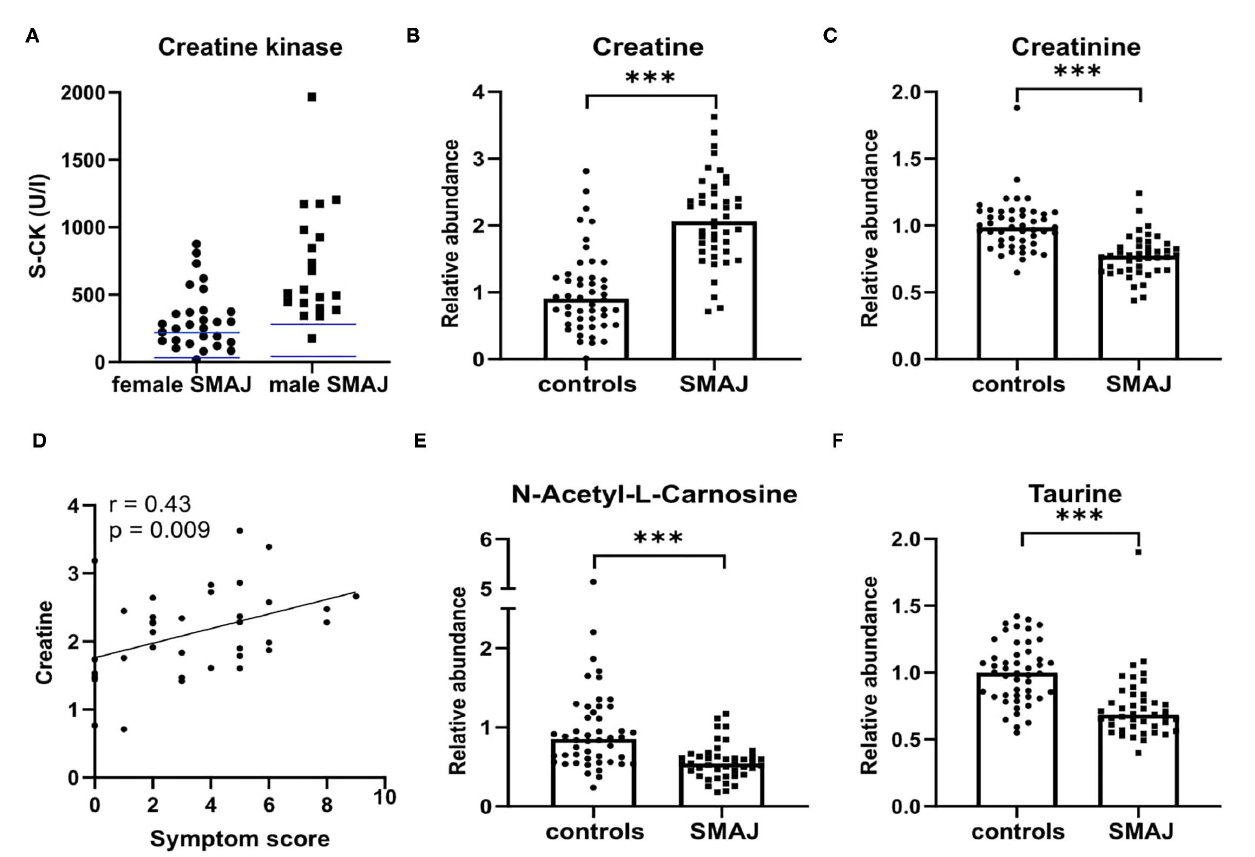
FIGURE 2 | Biomarkers of muscle damage and mass in SMAJ. (A) Creatine kinase (S-CK) units of enzyme activity per liter of serum in female ( n = 29) and male ( n = 20) patients with SMAJ. Blue lines indicate the upper and lower age- and sex-matched laboratory reference values. Comparison of (B) creatine and (C) creatinine values between patients with SMAJ ( n = 43) and controls ( n = 48) measured with a mass spectrometer. Correlation of (D) creatine to a symptom score by Spearman correlation test n = 36. Comparison of (E) N-acetyl-L-carnosine and (F) taurine values between patients with SMAJ ( n = 43) and controls ( n = 48) measured with a mass spectrometer. For comparisons, median per group is indicated by a bar. *** p < 0.0001, Mann–Whitney U -test.